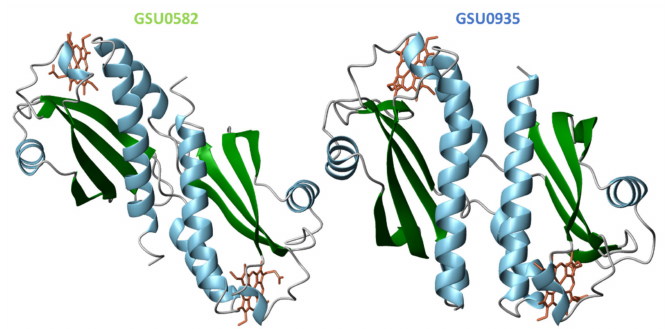
Figure 13. Structure of the sensor domains GSU0582 (PDB: 3B47) and GSU0935 (PDB: 3B42) in the oxidized form. α -helices and β -strands are represented in green and blue, respectively. The heme groups are represented in orange.